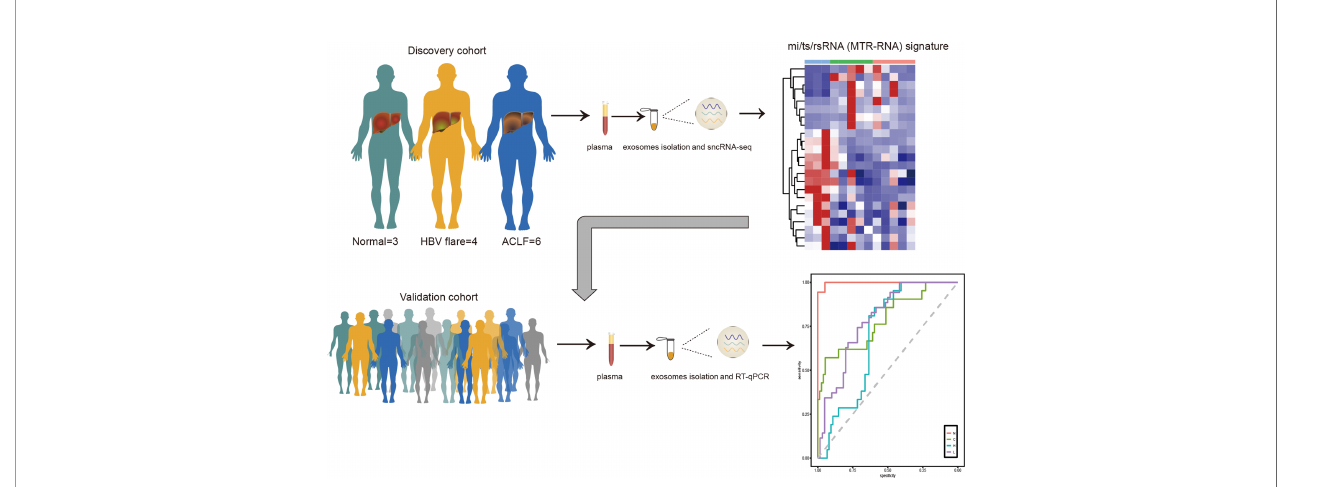
FIGURE 6 | The MTR-RNA signature in HBV-ACLF. Plasma exosome mi/ts/rsRNA (MTR-RNA) expression of the discovery cohort subjects was pro fi led by sncRNA- seq. The molecular signature containing mi/ts/rsRNAs was developed to discriminate between healthy controls (N), HBV-associated cirrhosis or CHB patients (C), CHB patients with fl are (H), and HBV-ACLF subjects